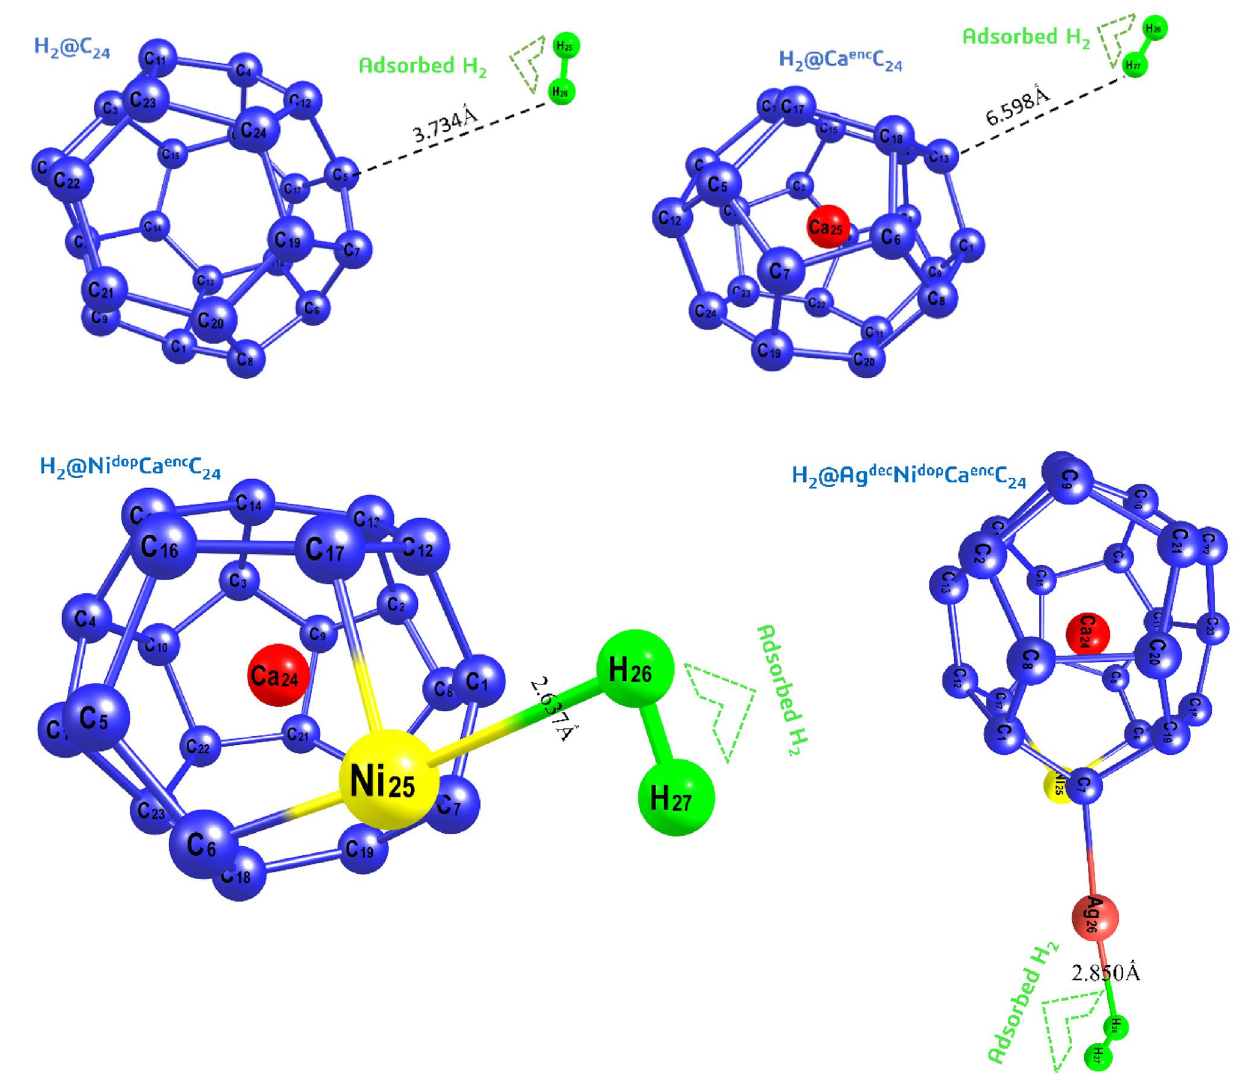
Figure 7. Structurally optimized structures of molecular hydrogen adsorption on the considered nanoclusters exhibiting the bond length of